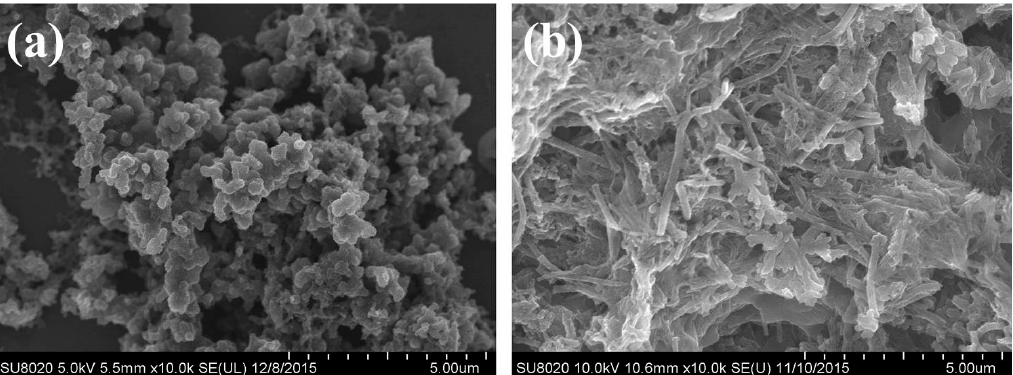
Figure 6. SEM images of the samples prepared at CA/Ani = 0.5, APS/Ani = 1, ( a ) at room temperature for 24 h; ( b ) at ice bath with mechanical stirring for 24 h.